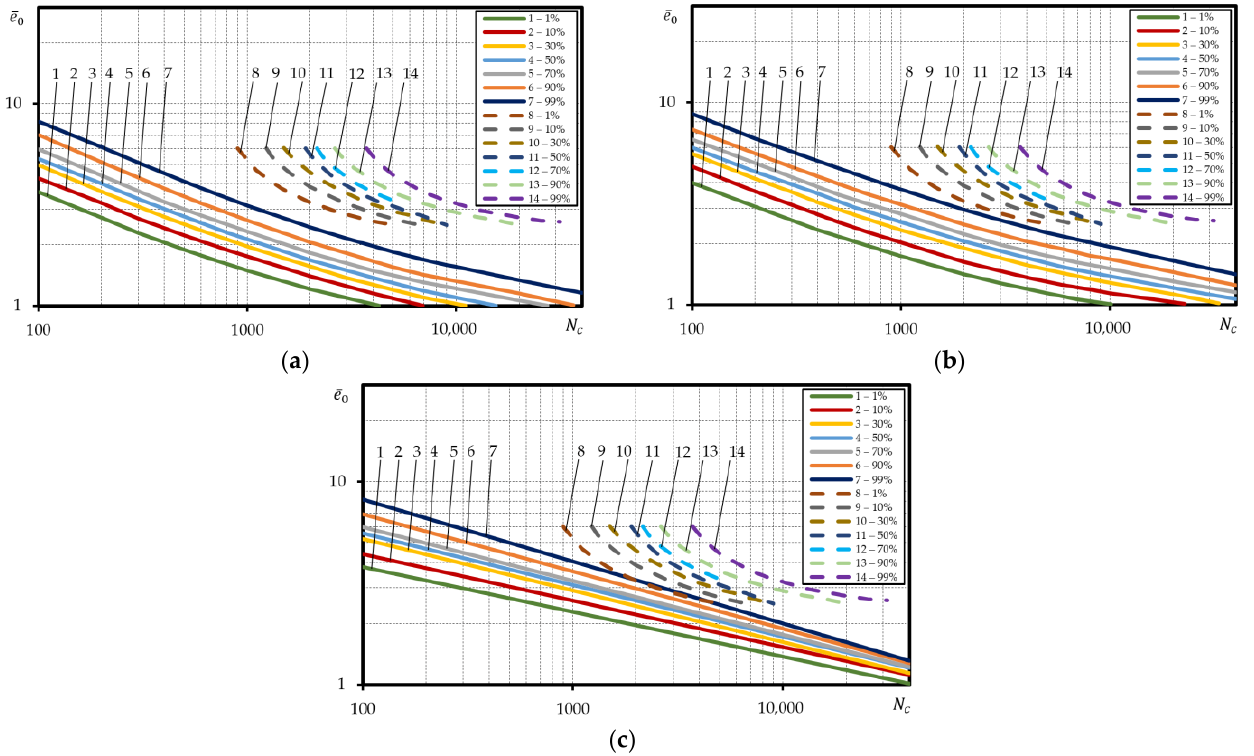
Figure 9. Comparison of the calculated probabilistic low-cycle fatigue curves under strain-controlled loading with the experimental ones for steel C45; straight lines—calculated, dashed lines—experiment; according to: ( a ) — Equation (3), ( b ) — Equation (5), ( c ) — Equation (6).